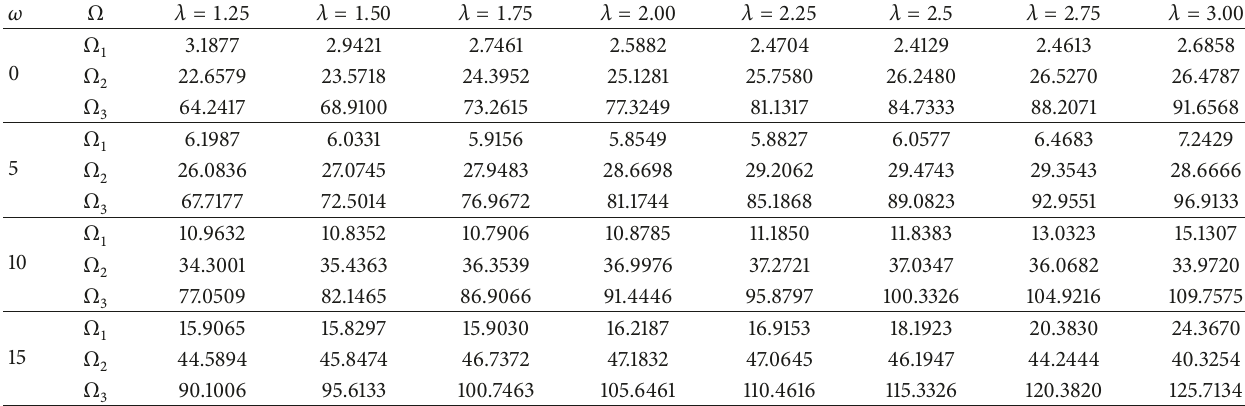
Table 3: The first three dimensionless natural frequencies of rotating solid tapered Rayleigh beams for different 𝜆 (1.25 ≤ 𝜆 ≤ 3) at 𝑟 0 = 0 , 𝛽 = 0 , 1/𝑟 = 30